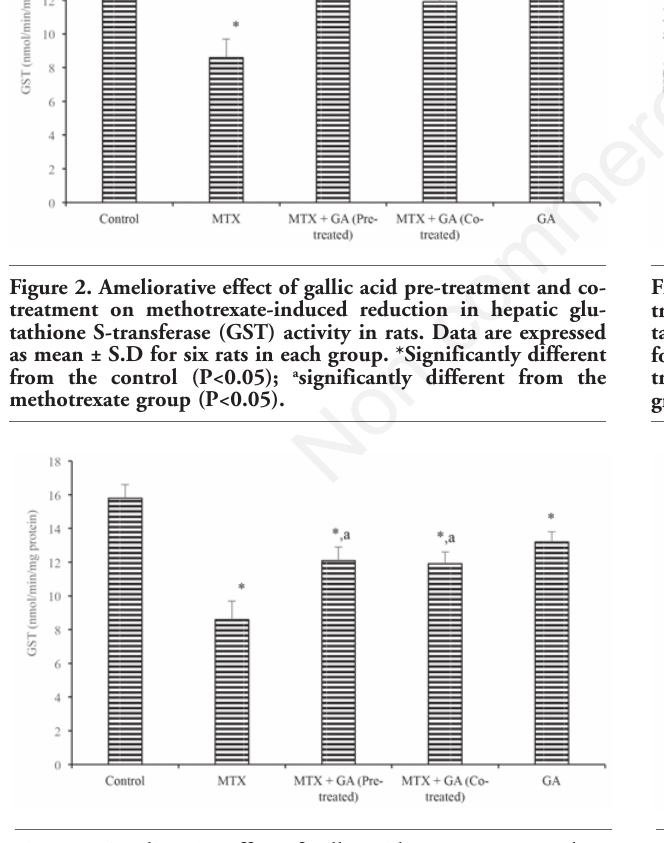
Figure 5. Ameliorative effect of gallic acid pre-treatment and co-treat- ment on methotrexate-induced increase in hepatic level of lipid per- oxidation (MDA) in rats. Data are expressed as mean ± S.D for six rats in each group. *Significantly different from the control (P<0.05); a significantly different from the methotrexate group